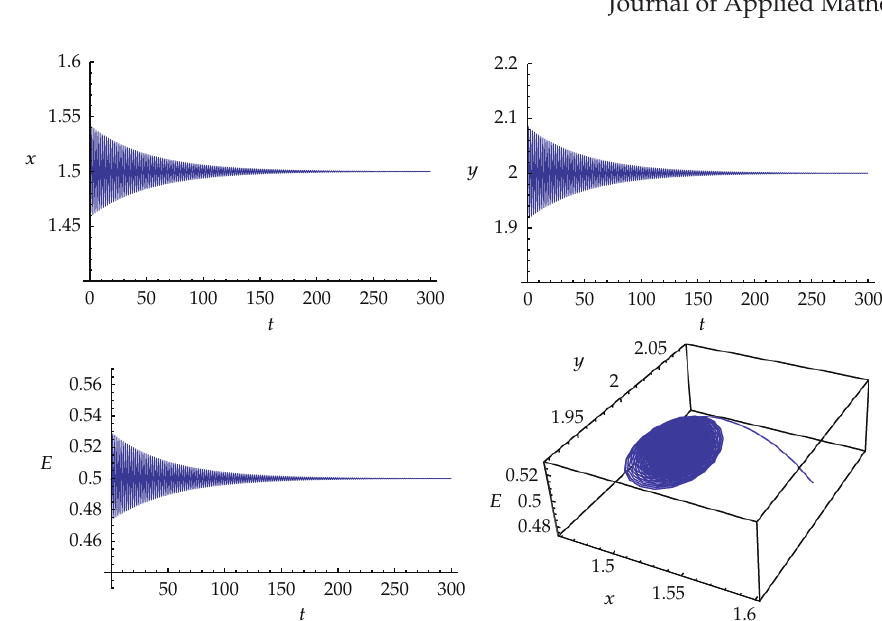
Figure 1: : Dynamic behavior of the di ff erential-algebraic system (cid:6) 3.1 (cid:7) with τ (cid:5) 0 . 55 < τ (cid:8) equilibrium point P (cid:8) is